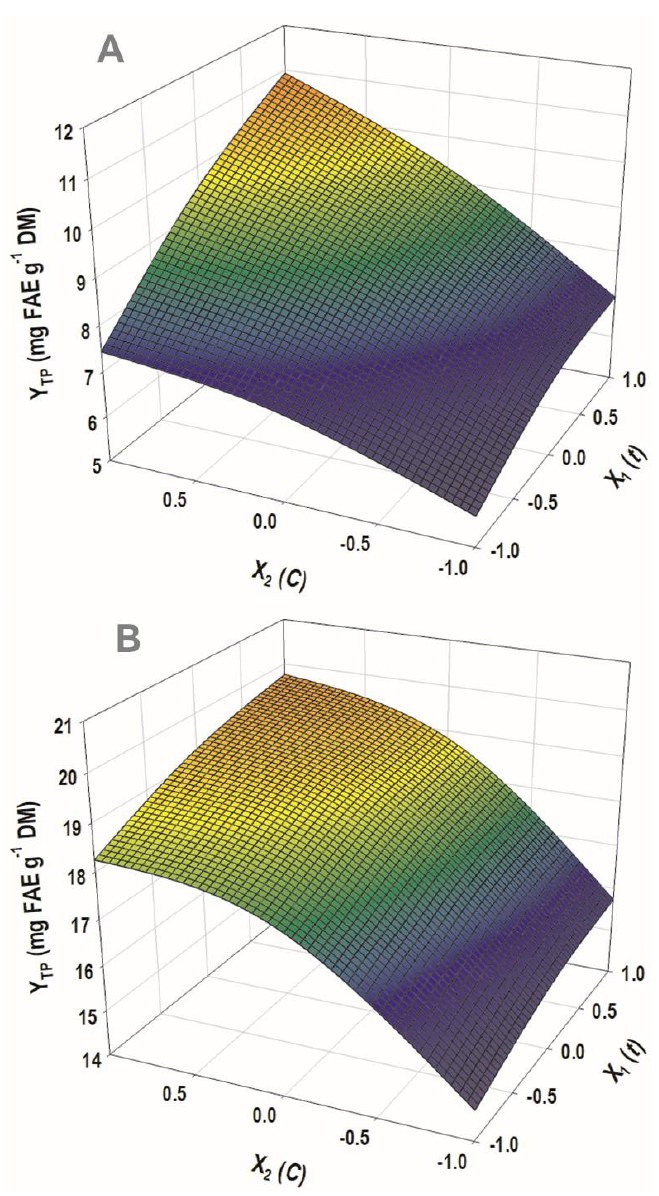
Figure 5. The 3D diagrams representing the effect of the process variables ( C , t ) on the yield in total polyphenols (Y TP ). A , sulfuric acid-catalyzed process; B , sodium hydroxide-catalyzed process.